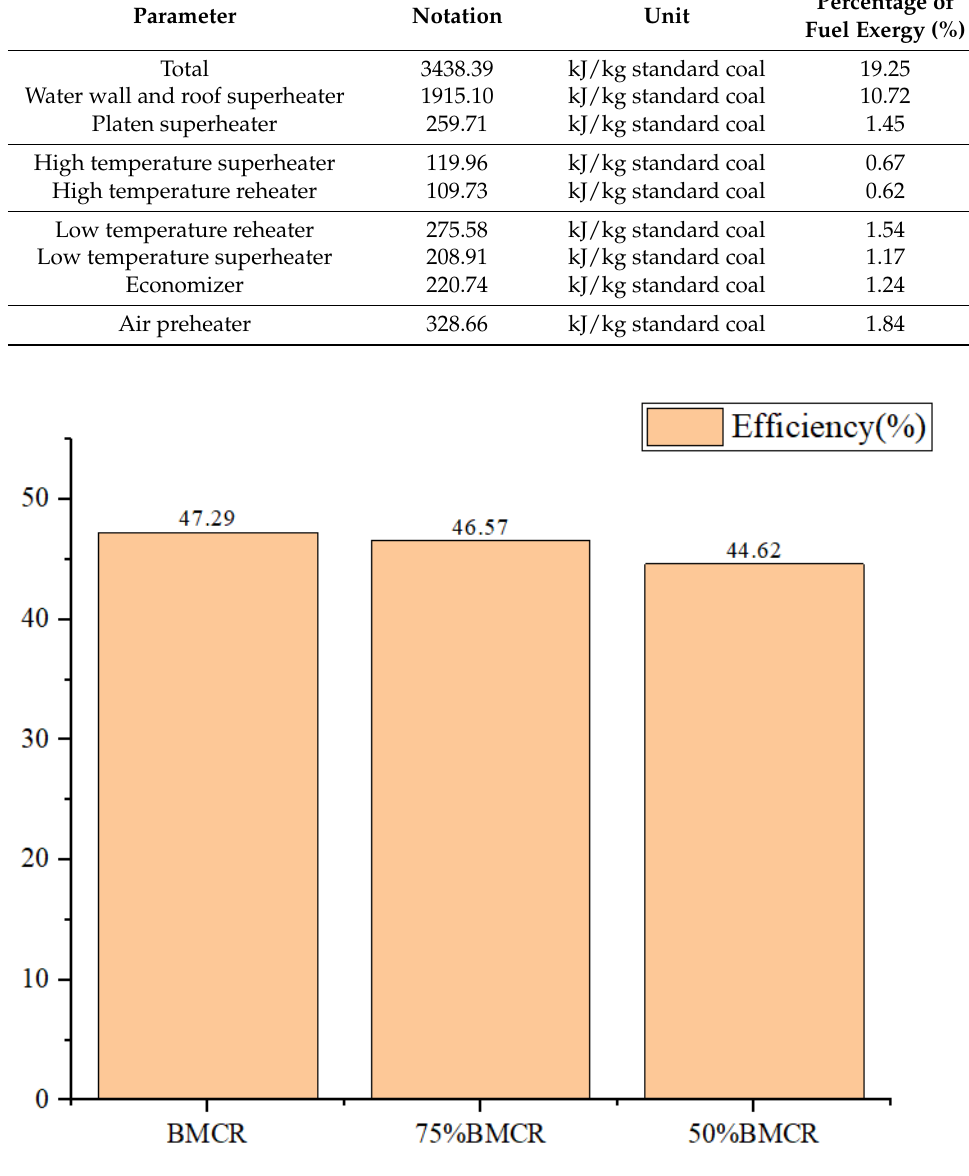
Figure 8. Boiler overall exergy efficiency changes with load.